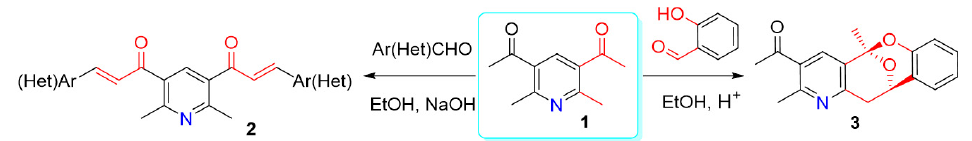
Figure 1. Structures of antiviral drugs against the SARS-CoV-2 virus that have or had clinical approval.